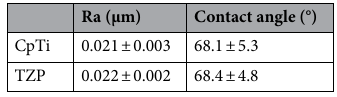
Table 1. Ra and contact angle.